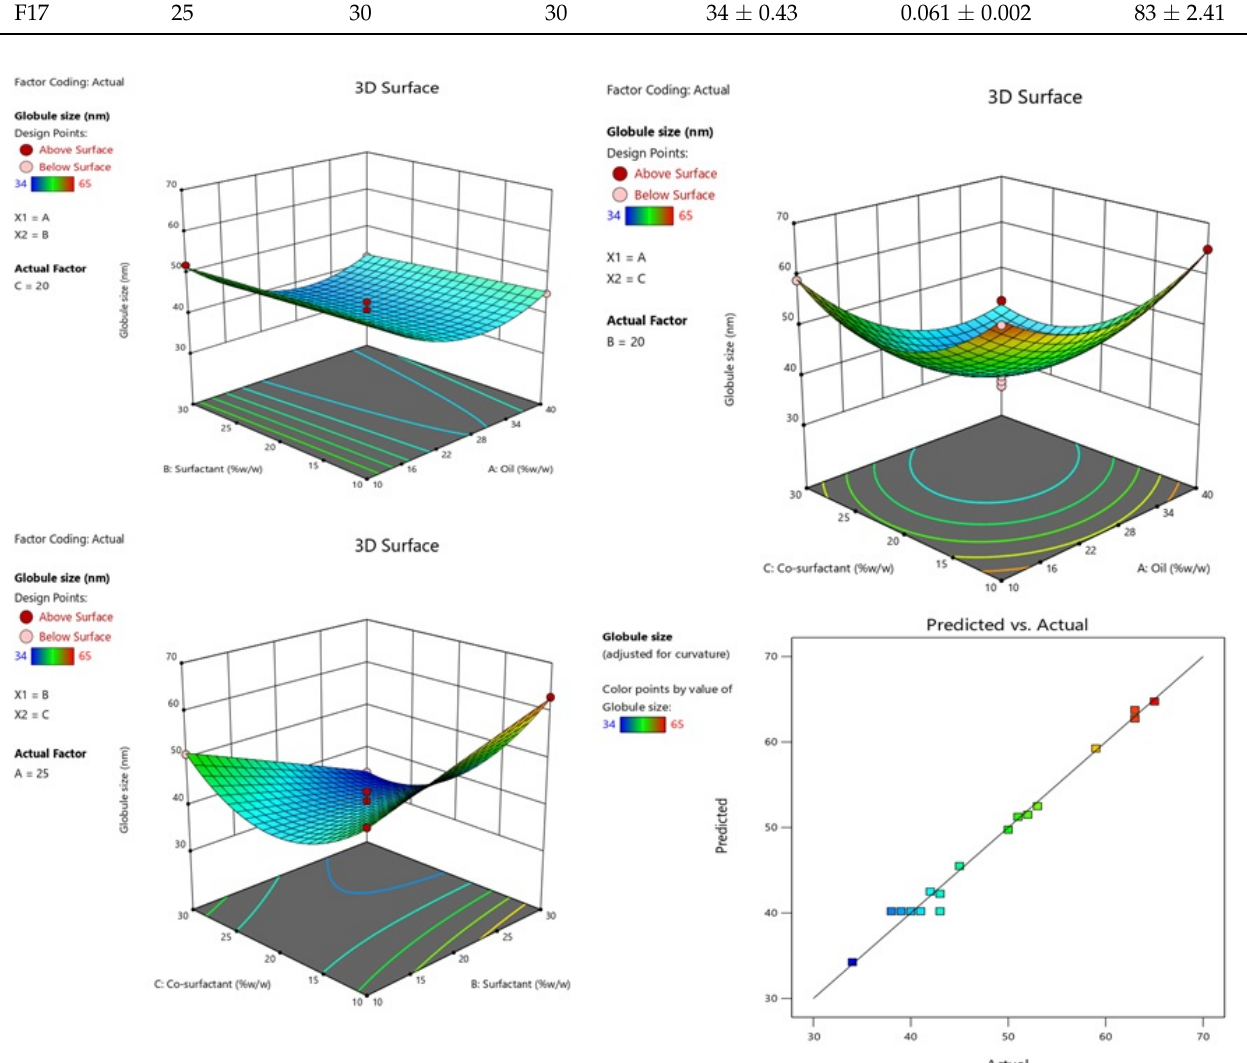
Figure 2. Effect of conc. of oil and surfactant and co-surfactant on globule size, and plot of and actual and and predicted.